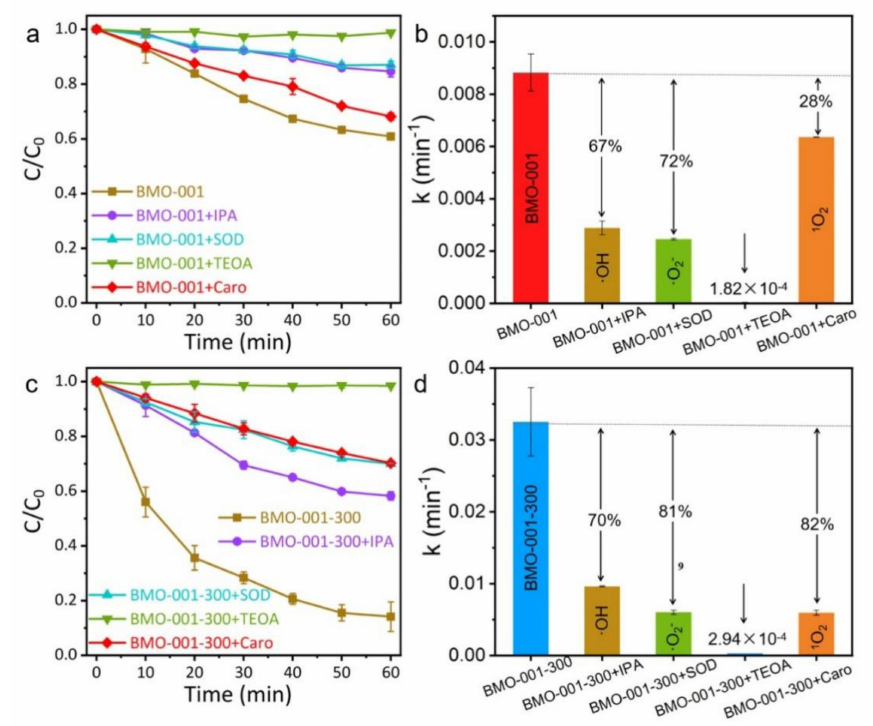
Figure 4. Photocatalytic NaPCP degradation performance curve and reaction rate on BMO- 001 ( a , b ) and BMO-001-300 ( c , d ) with different scavengers (TEOA → h + , IPA →• OH, SOD →• O 2 − , caro → 1 O 2 ) under visible light irradiation, respectively.